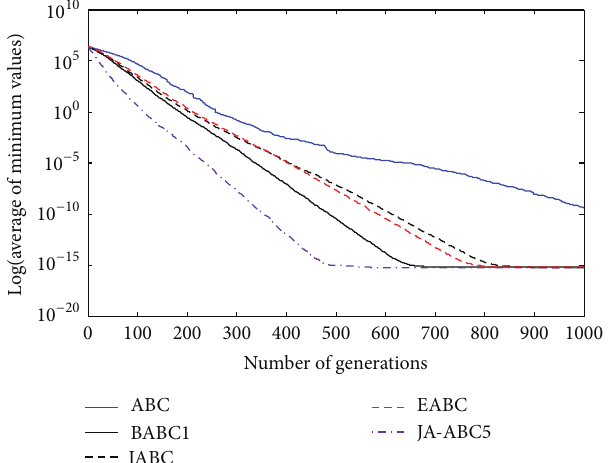
Figure 4: The convergence rates of optimization algorithms on Random Shifted Sphere function.